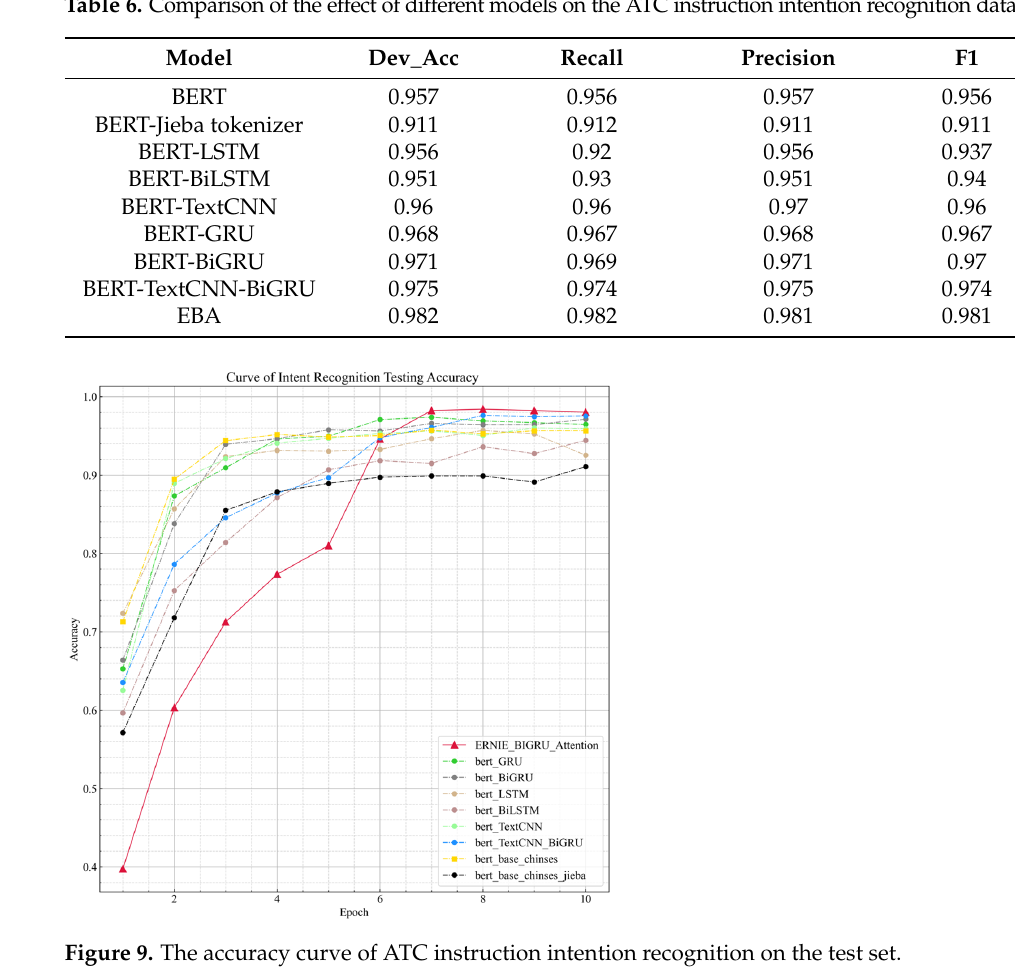
Table 6. Comparison of the e ff ect of di ff erent models on the ATC instruction intention recognition dataset.